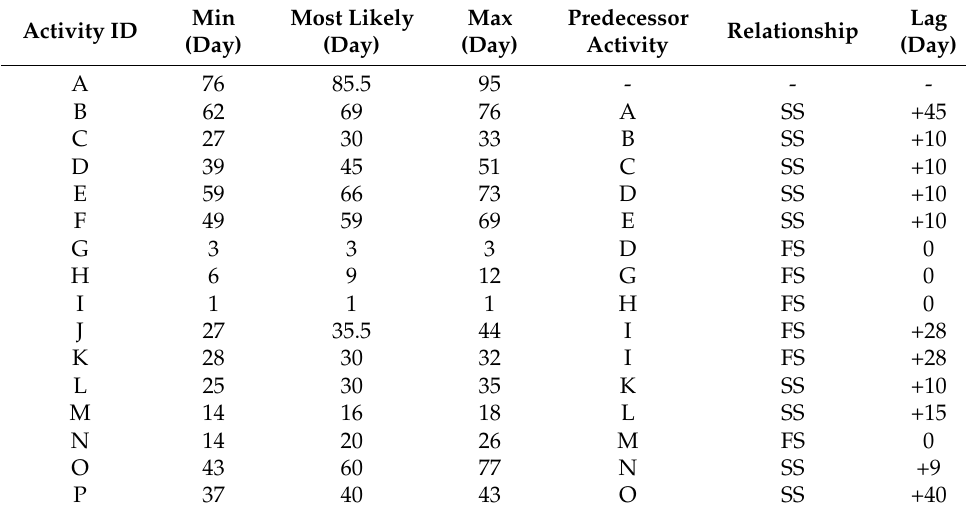
Table 2. Duration and connections of phase